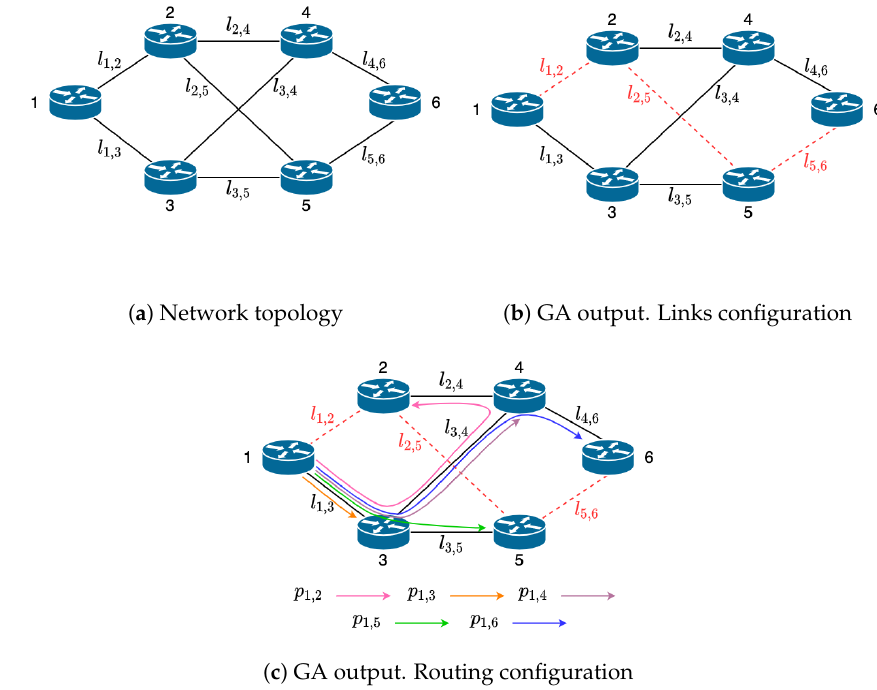
Figure 2. Example of GA output on a 6-node topology. ( a ) Network topology. ( b ) GA output. Links configuration. ( c ) GA output. Routing